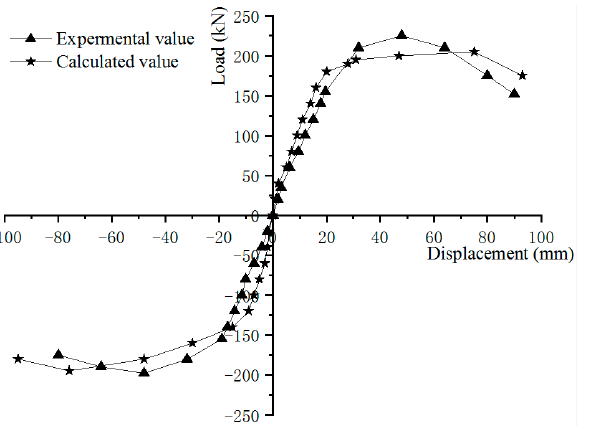
Figure 19. The comparison between the KJ-2 curve and the curve of the finite element analysis.